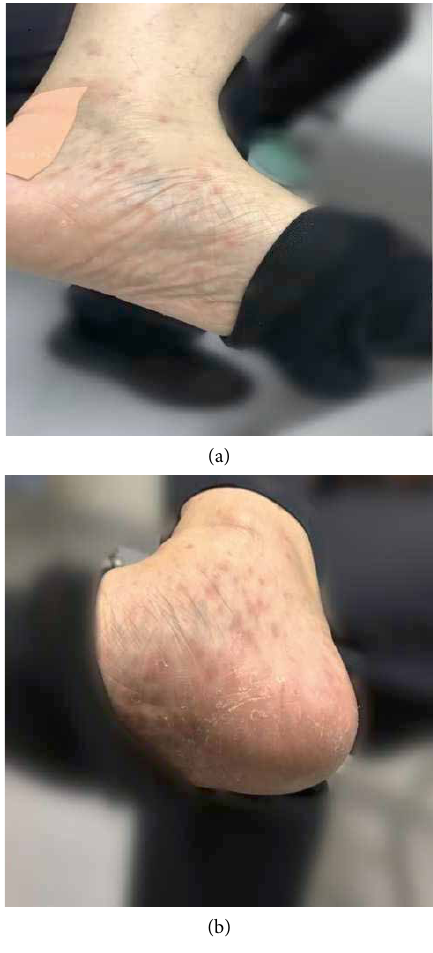
Figure 4: Bilateral palms and soles had multiple copper-red macula and papules some of which were desquamated on the surface. ((a): left sole, (b): right